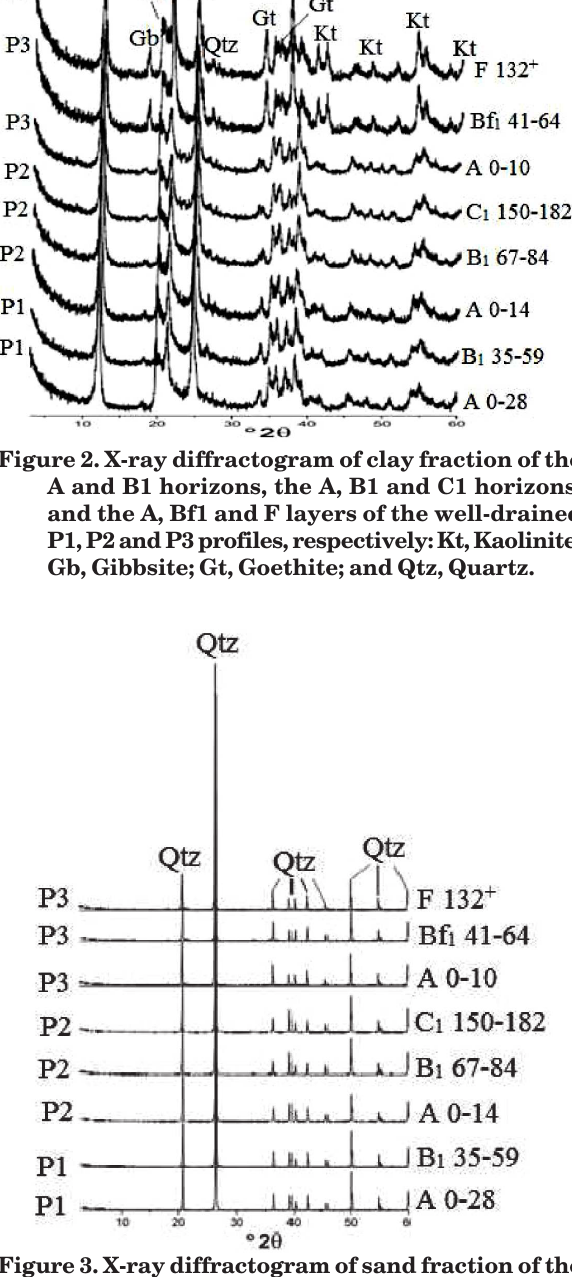
Figure 3. X-ray diffractogram of sand fraction of the A and B1 horizons, and the A, B1 and C1 horizons, and the A, Bf1 and F layers of the well-drained P1, P2 and P3 profiles, respectively: Qtz, Quartz.